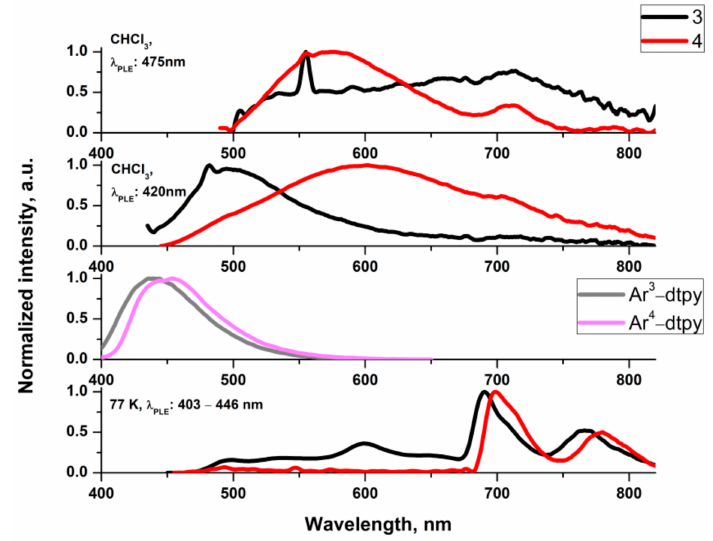
Figure 6. Emission spectra of 3 (black line), 4 (red line) and corresponding ligands Ar 3 -dtpy (grey line) and Ar 4 -dtpy (pink line) in detreated solutions CHCl 3 (concentration 25 µ M) and in the rigid matrix (MeOH:EtOH 1:4) at 77 K.